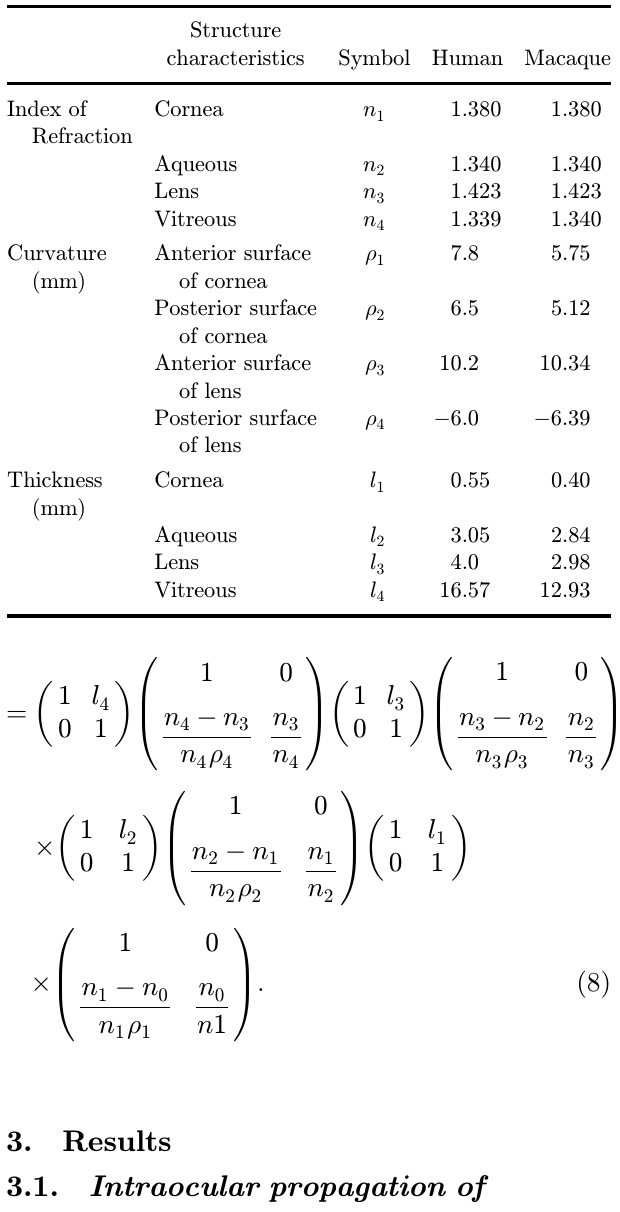
Table 1. Geometrical characteristics of schematic eye